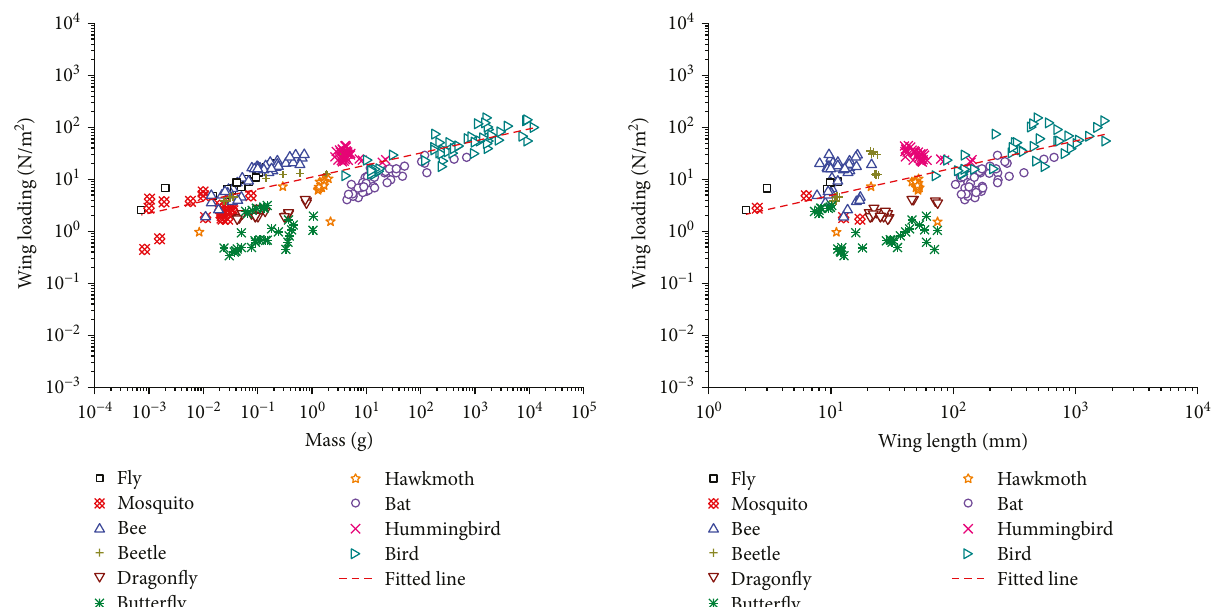
Figure 5: The relation of wing loading vs. mass (left), and wing loading vs. wing length (right).